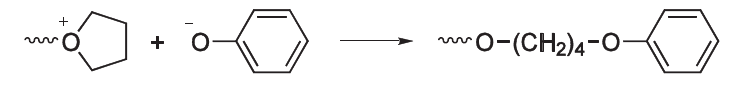
Figure 29. Reaction of the CROP growing chain ends with a phosphine to allow quantitative